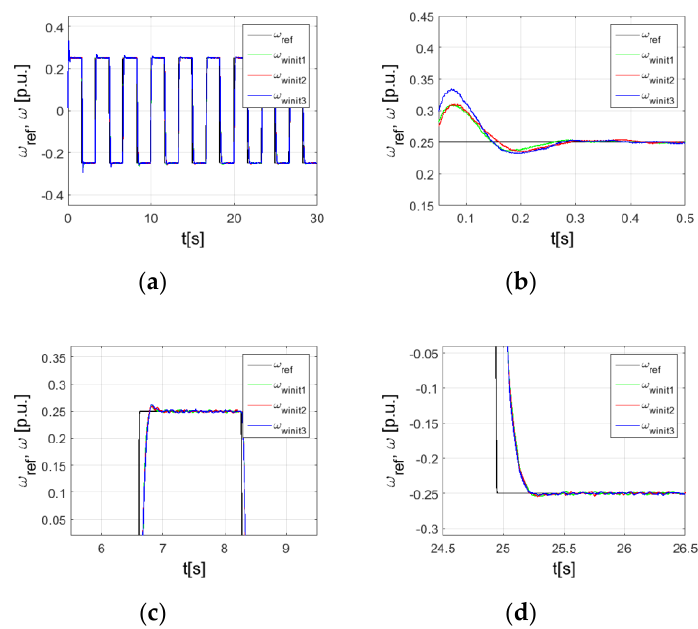
Figure 12. Transients of speed ( a – d ) measured in the DFOC structure with PI speed controller and the RBFNN compensation—influence of initial weight randomization (comparison).